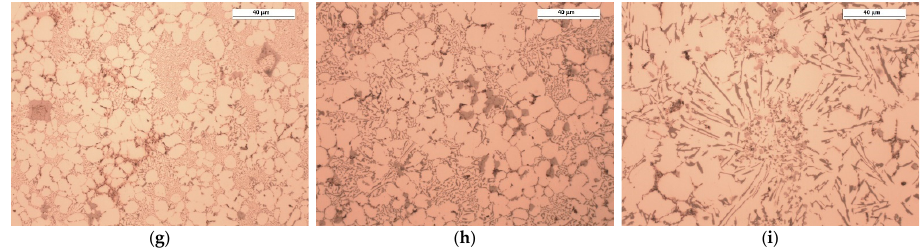
Figure 8. Microstructure of the tested Al-Si-Cu alloy in areas with different wall thicknesses in test castings according to Table 3: series 1 ( a – c ), series 5 ( d – f ), and series 15 ( g – i ); unetched. 3 mm